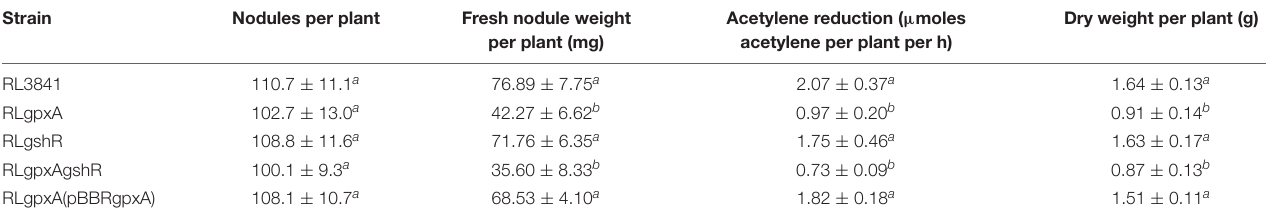
TABLE 3 | Symbiotic behavior of R. leguminosarum mutants. Strain Nodules per plant Fresh nodule weight